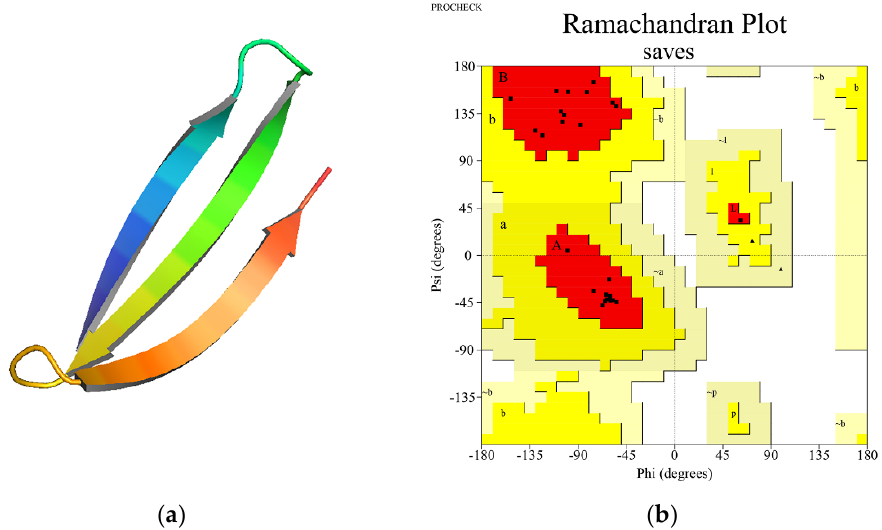
Figure 3. ( a ) 3D structure visualization of one synthetic long peptide, PINLVRDLPQGFSALLLSVGGWTAGAAAYY, using PyMol; ( b ) Ramachandran plot for the corresponding SLP. The dots representing the amino acids are mainly located in the most favorable regions (red) or the additional allowed regions (yellow). Most amino acids are located in the beta-sheet and alpha-helix regions.